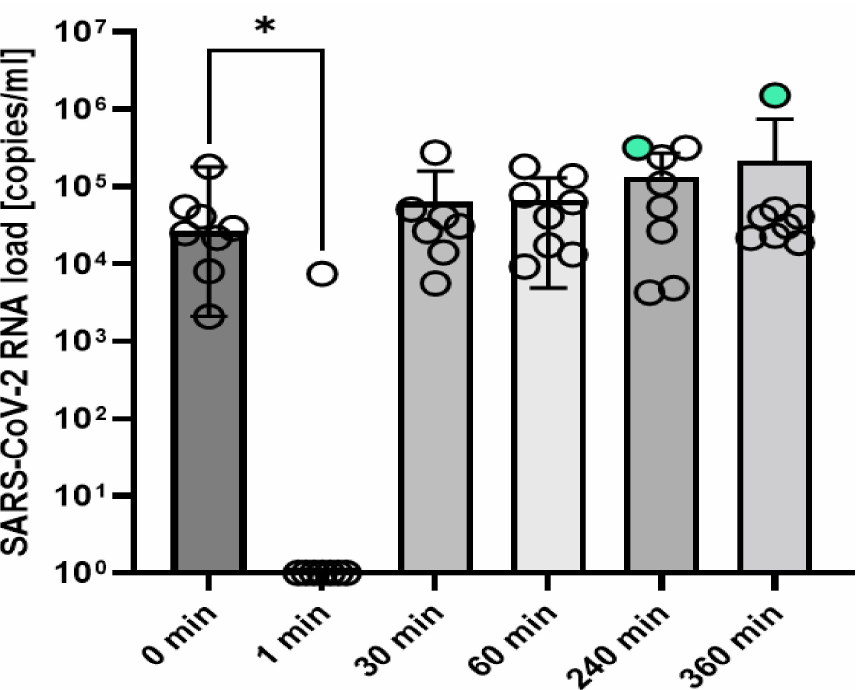
Figure 1. Octenidine dihydrochloride (OCT) plus phenoxyethanol effectively reduces detectable viral RNA in the saliva of SARS-CoV-2 positive individuals. SARS-CoV-2 RNA levels in the saliva of 8 subjects as quantified by RT-qPCR pre-rinsing with OCT plus phenoxyethanol (0 min) and 1, 30, 60, 240 and 360 min after rinsing with OCT plus phenoxyethanol are illustrated. RNA levels < LoD were set to 1 × 10 0 copies/mL to allow for logarithmic presentation. Median RNA levels for each time point and 95% CI are indicated. Significant differences are indicated by asterisk (* = p < 0.05, unpaired t -test). Circles represent individual participant values with circles highlighted in light turquoise represent infectious samples as proved by successful virus